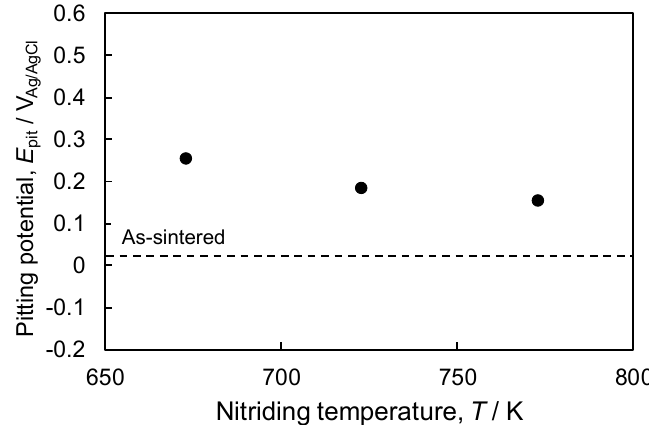
Figure 14. Pitting potential of plasma-nitrided CoCrFeMnNi samples.